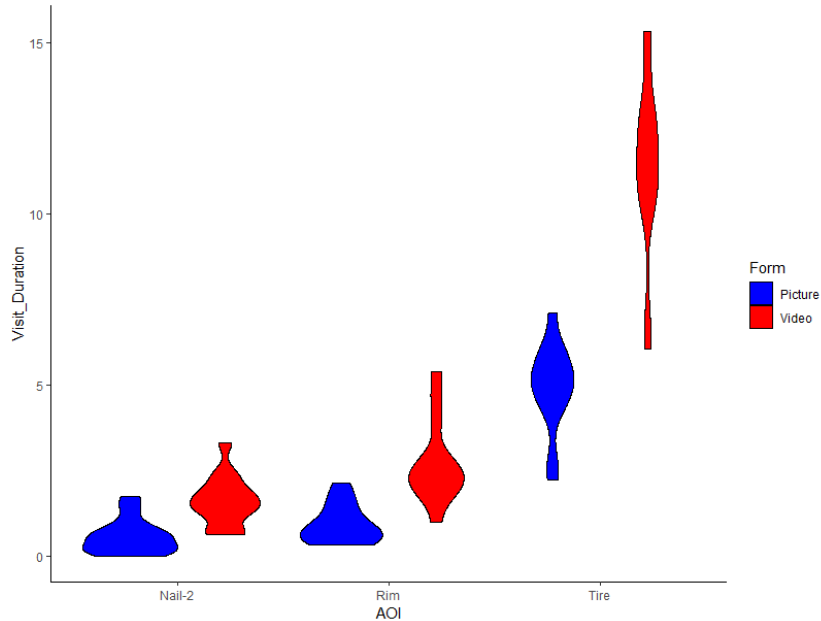
Figure 10. Violin plots highlighting the most significant differences on TVD Diff% between forms of representation for the product Tire.